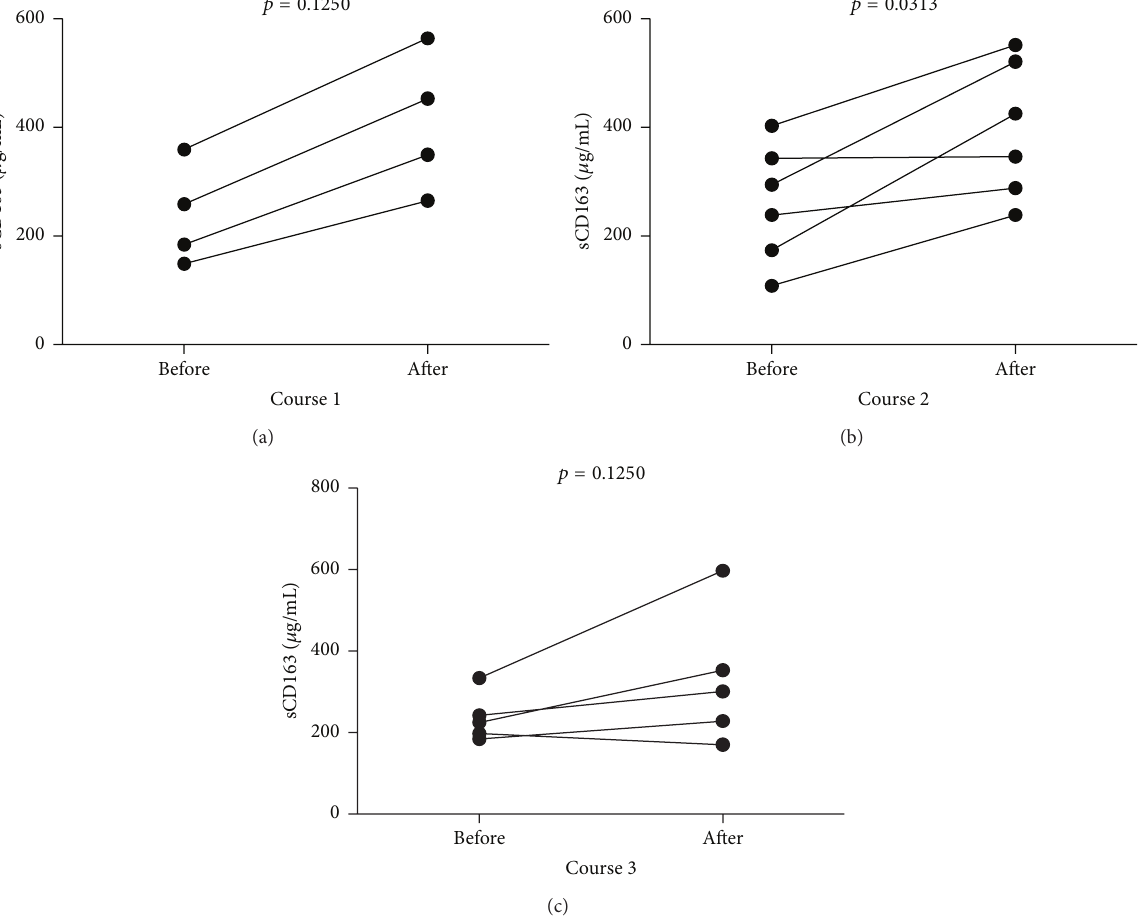
Figure 5: Time course changes in sCD163 plasma levels after (a) course 1, (b) course 2, and (c) course 3 of G-CSF administration in MD pediatric